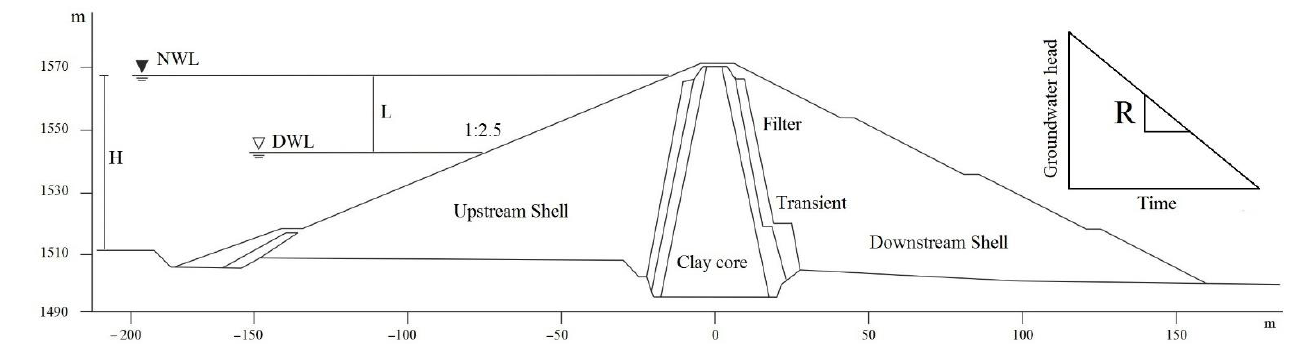
Figure 1. The cross-sectional layout for the Alavian Dam. Table 2. Geotechnical properties for the Alavian dam’s seepage and slope stability